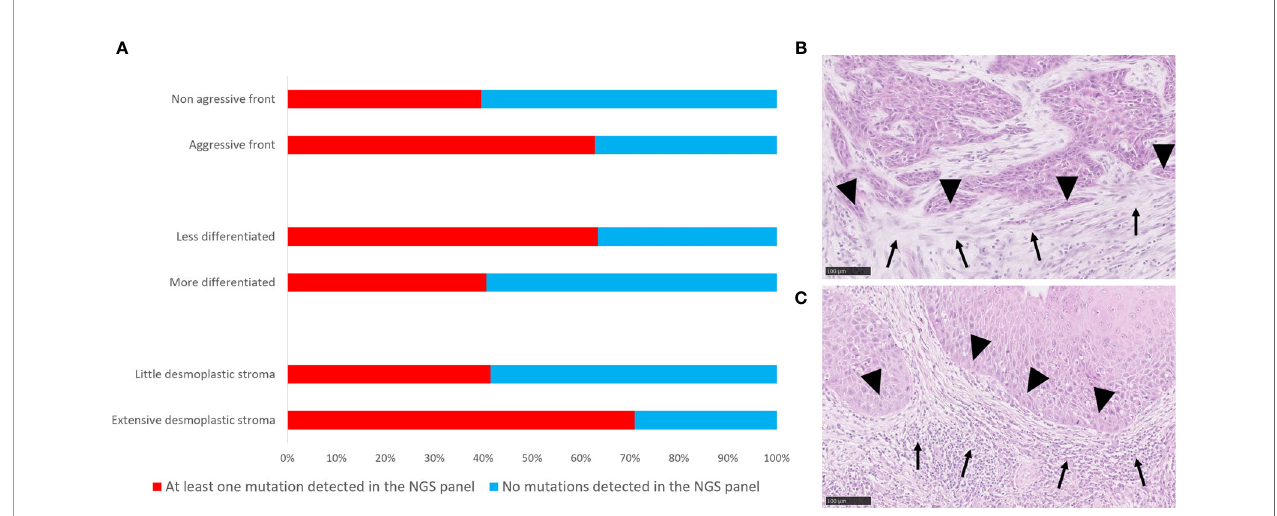
FIGURE 6 | Correlations of mutational landscape with histopathological parameters. (A) Bar graph showing distribution of cases with at least one mutation and without mutations in the genes targeted by the NGS panel according to histopathological parameters. (B) Histological picture of a tumour with at least one mutation detected by targeted NGS panel, and an extensive stromal desmoplastic response (solid arrows), an aggressive invasive tumour front (solid arrowheads), a less differentiated phenotype and a poor in fl ammatory response. (C) Histological representation of a tumour with no mutations detected by targeted NGS panel and a little stromal desmoplastic response, non-aggressive invasive tumour front (solid arrowheads), a more differentiated phenotype and an intense in fl ammatory response (solid arrows). Scale bar = 100 m